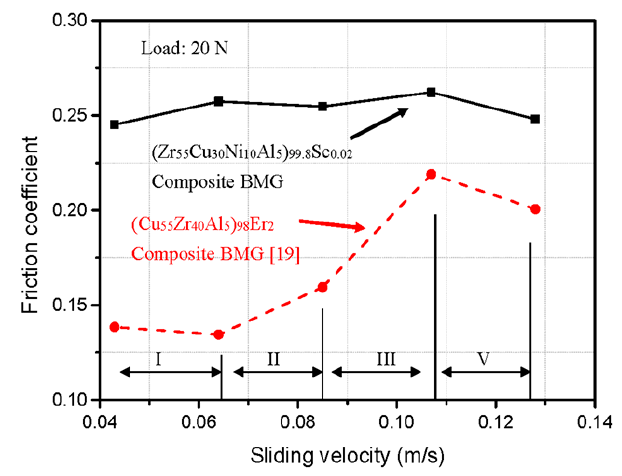
Figure 4. The relationship between the average coe ffi cient versus sliding velocity for two composite BMGs under the same load of 20